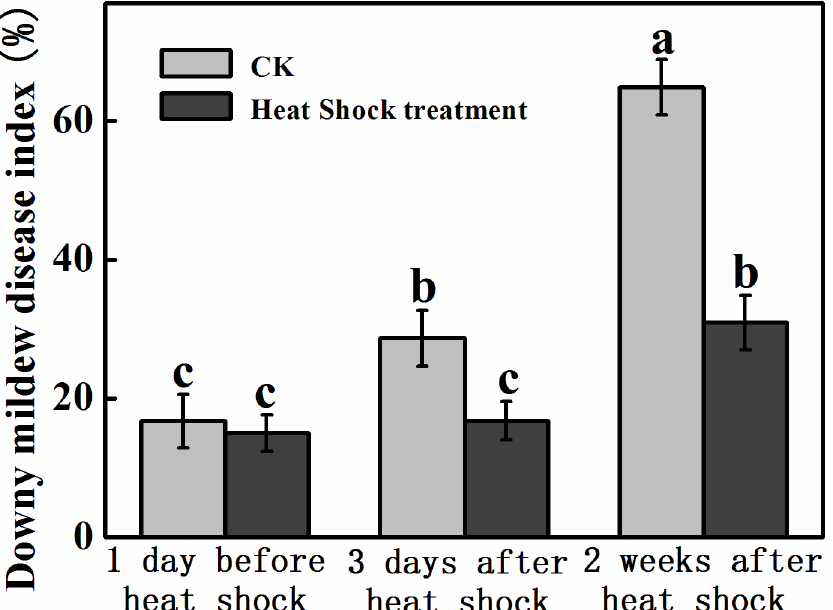
Fig 7. Effects of heat shock on downy mildew disease index of plants at different greenhouses. The data represent the mean ± SE (n = 5). Different letters indicate significant differences at P < 0.05 based on the Least Significant Difference